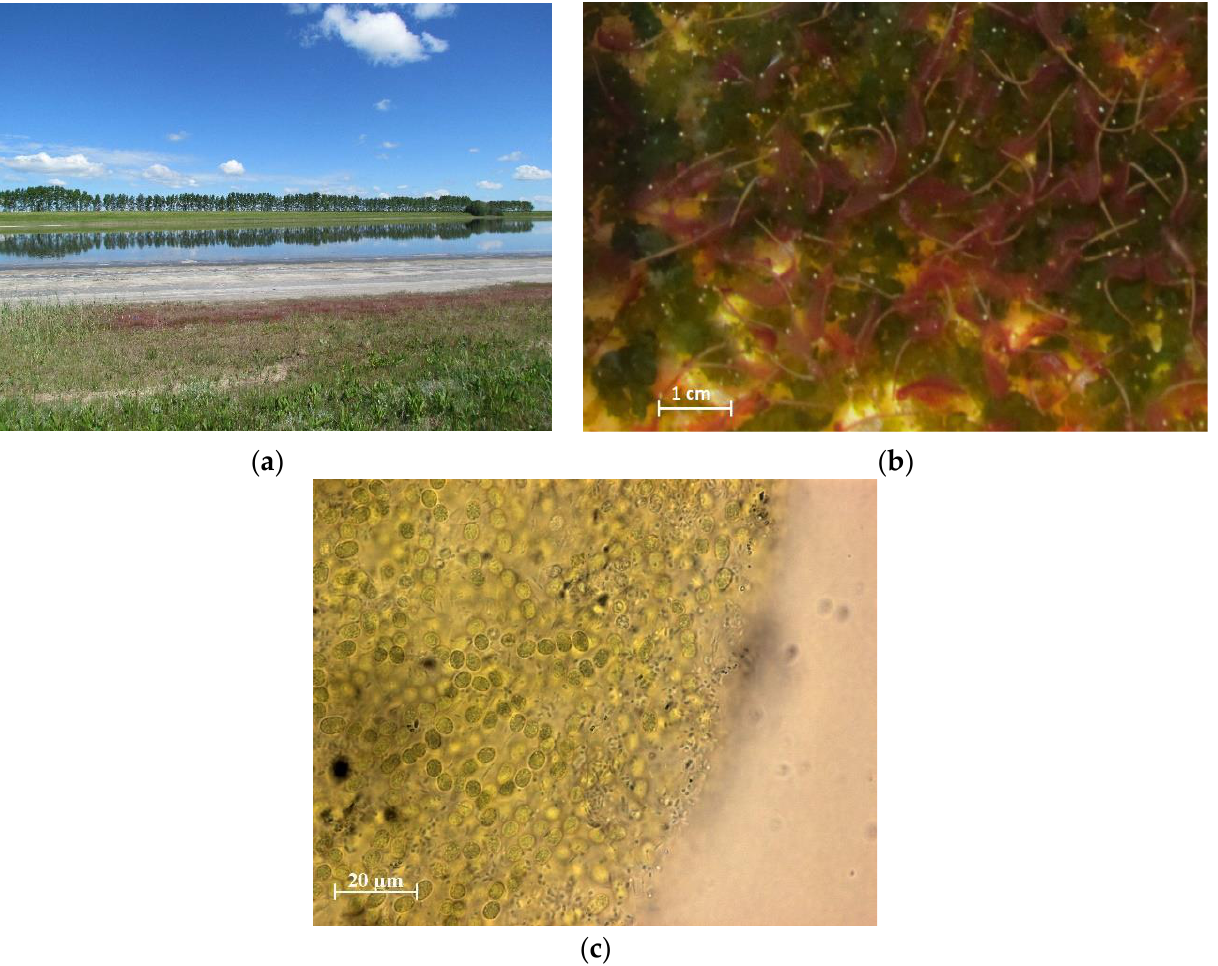
Figure 1. The coastal strip of Lake Solenoe ( a ). Loose cyanobacterial mass among Artemia sp. individuals ( b ). A colony of cyanobacteria from the R1 layer ( c ).